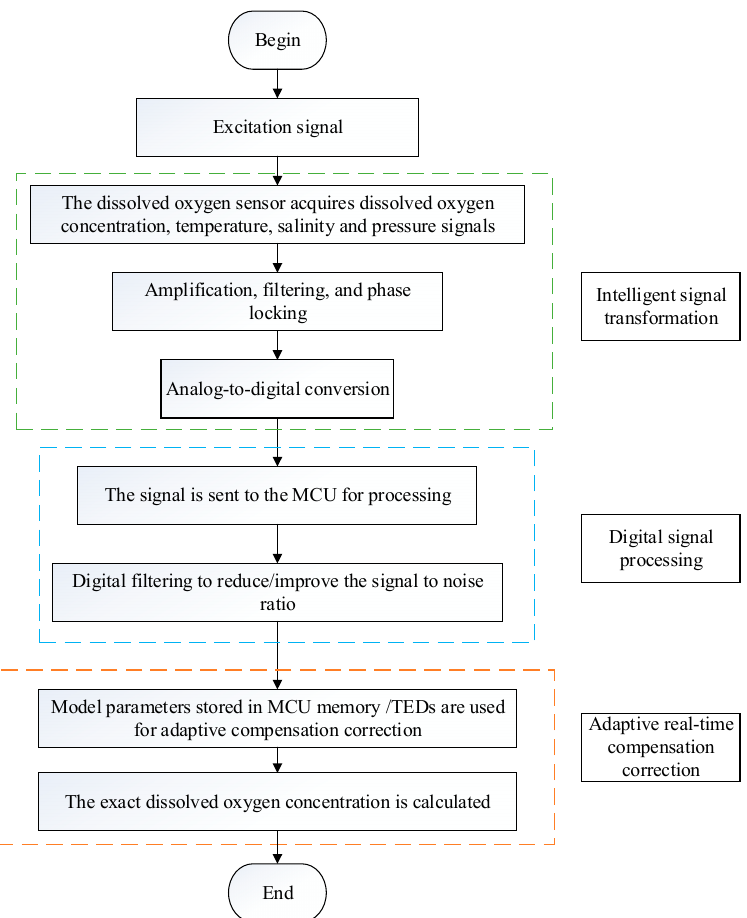
Figure 4. The signal processing flow of the intelligent dissolved oxygen sensor.